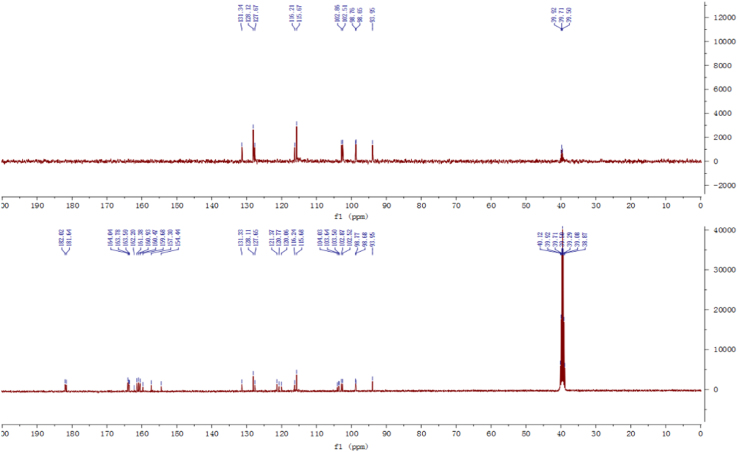
13C-NMR spectrum of compound 12.